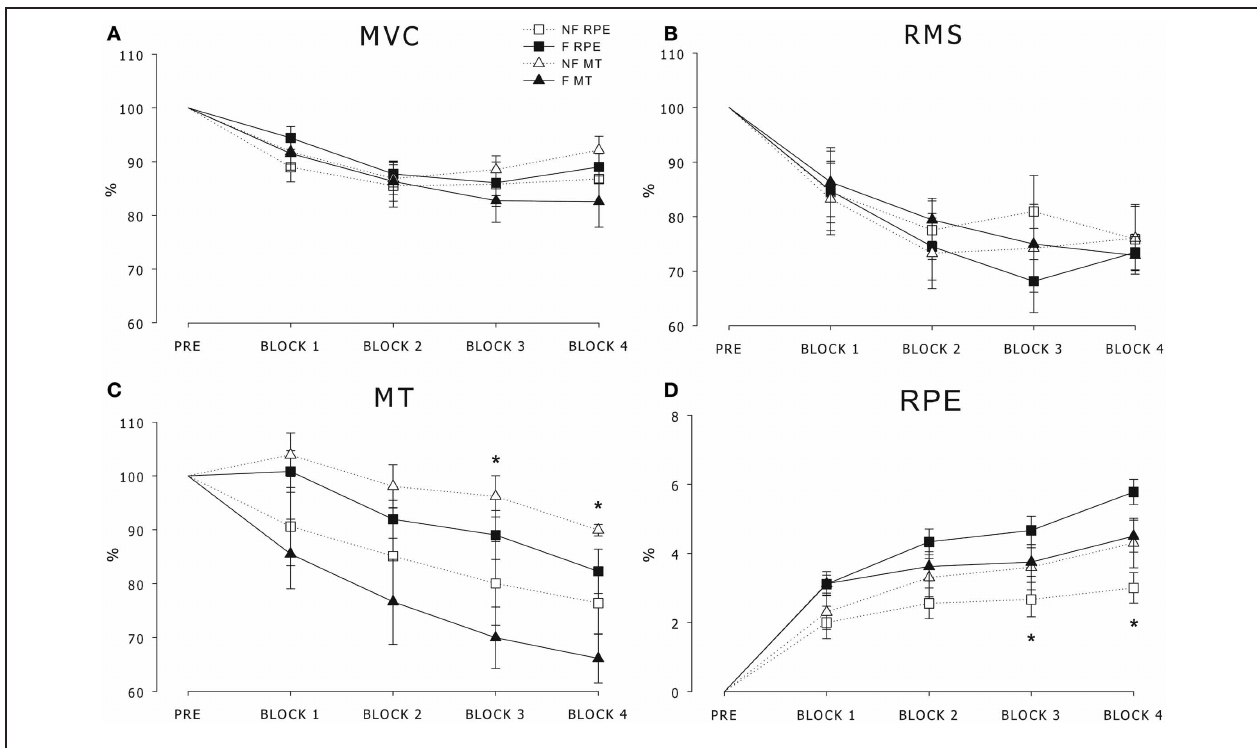
FIGURE 2 | (A) Maximal voluntary contraction (MVC) force, (B) root mean square (RMS) of the EMG signal, (C) maximal twitch (MT) and (D) rating of perceived effort (RPE) over time in the F-MT and NF-MT cohorts (triangles)